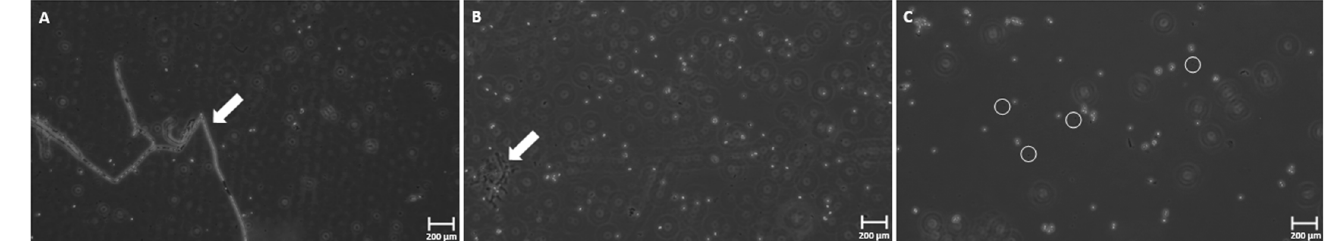
Figure 5. Phase-contrast microscopy images (20× magnification) of the commercial apple juice inoculated with B. nivea ascospores in spores activated at 80 ◦ C/30 s stored for 10 days at atmospheric pressure (AP) at room temperature (RT) ( A ), and 30 days under refrigeration at 4 ◦ C ( B ) and under hyperbaric storage at 150 MPa at RT ( C ). The white arrow highlights hyphae formation, while the white circles highlight dead ascospores (displayed as dark phase